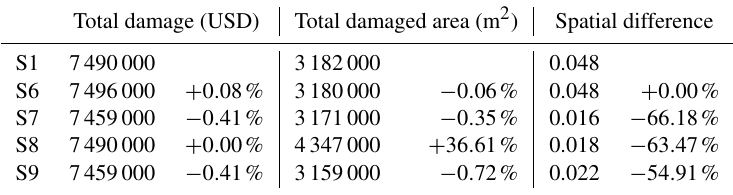
Table 6. Calculated total damage, total damaged area and spatial difference for S6, S7, S8 and S9 in comparison to S1. Total damage (USD) Total damaged area (m 2 ) Spatial